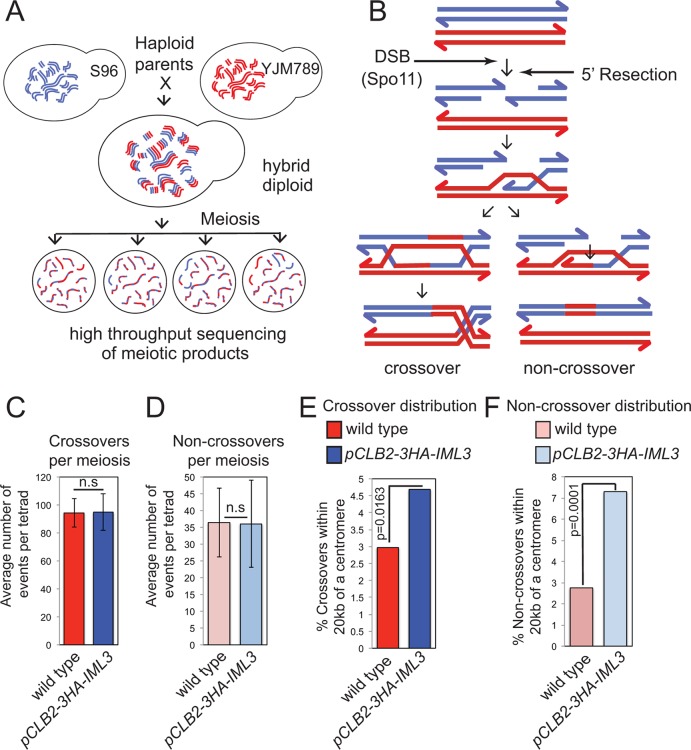
Genome-wide analysis shows that a functional Ctf19 complex is required to prevent both pericentromeric COs and NCOs.(A) Assay to measure meiotic recombination genome-wide by analysis of SNPs after high-throughput sequencing of germinated spores resulting from hybrid meiosis. (B) Scheme of meiotic recombination showing CO and NCO outcomes. (C, D) Overall recombination levels are not affected by the pCLB2-3HA-IML3 mutation. The average numbers of COs (C) and NCOs (D) per tetrad are not significantly different between wild type and pCLB2-3HA-IML3 cells. Error bars represent standard deviation. A two-tailed t test indicated non-significance (p>0.05). (E, F) Both COs (E) and NCOs (F) within 20 kb of the pericentromere are increased in pCLB2-3HA-IML3 cells. Data for wild type is from (Oke et al., 2014). Number of meioses scored was 8 for pCLB2-3HA-IML3 and 52 for wild type. p-values were calculated using chi-square test with Yates correction. CO, crossover; DSB, double strand break; NCO, non-crossover; SNPs, single nucleotide polymorphisms.